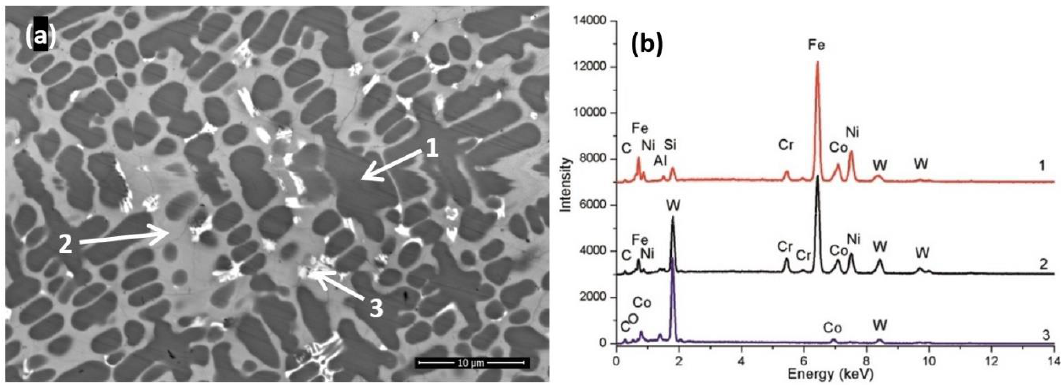
Figure 4. Back scattered electron micrograph of WC-Co/NiCrBSi coating ( a ) and EDX analysis ( b ).